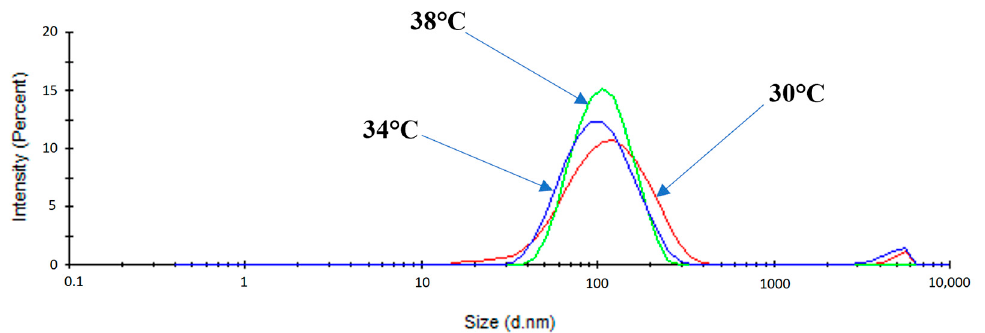
Figure 4. DLS investigation with nanoparticles’ dimensional distribution at various nanoprecipita- tion temperatures. Table 2. Particle size of PNIPAM/magnetite nanoparticles by DLS. Precipitation Temperature (°C)